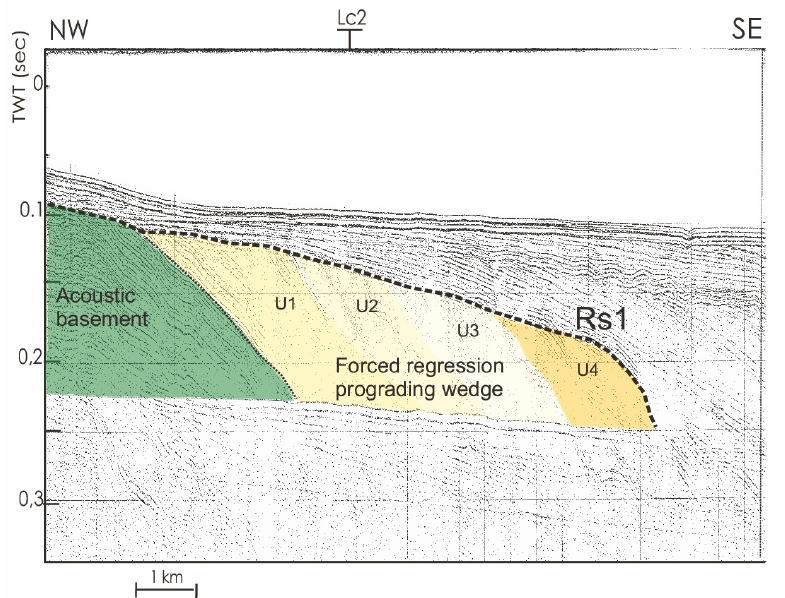
Figure 8. Line drawing of seismic profile showing the stratigraphic architecture of the pre ‐ 250 ky prograding wedge (W1). This is part of the seismic profile shown in Figure 5. W1 is genetically re ‐ lated to a Middle Pleistocene relative sea level fall induced by high rates of tectonic uplift over ‐ whelming the rate of glacio ‐ eustatic variation during the same time